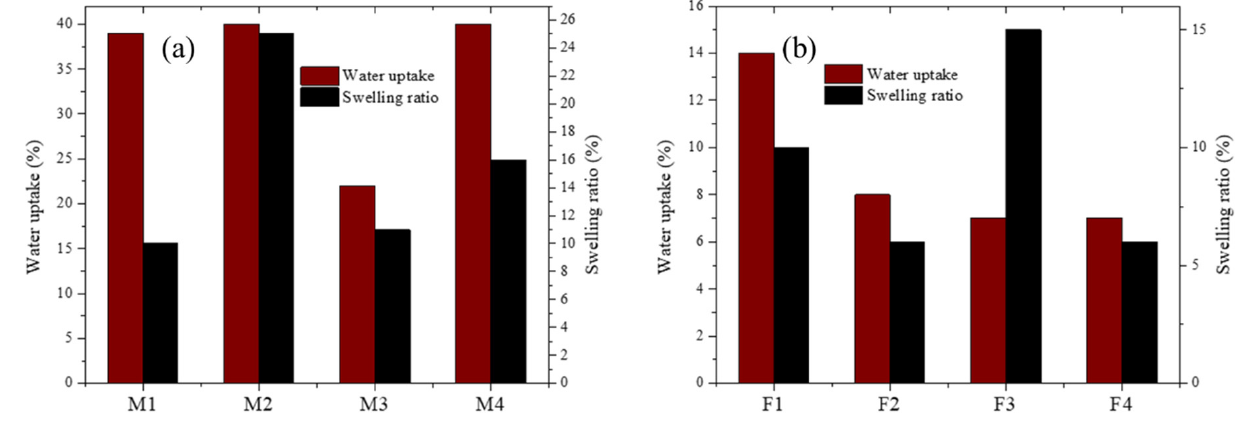
Figure 11. Swelling ratio and water uptake for membranes containing: ( a ) PEI and ( b ) Fumion ® . IEC and hydroxide conductivity values are shown in Table 3. Membranes with a higher PEI/Fumion ® content showed higher IEC values (milliequivalents per unit